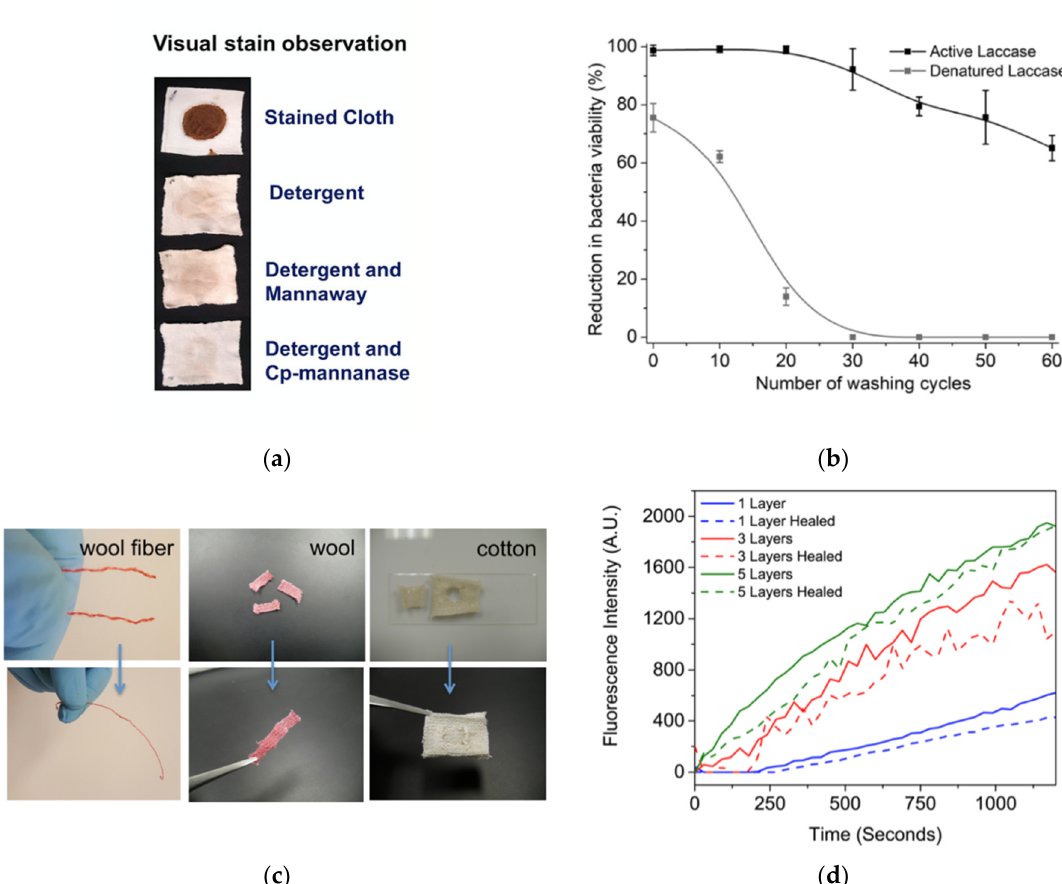
Figure 3. ( a ) Observation of chocolate stain removal as a result of enzyme and non-enzyme containing detergent washes. Reprinted with permission from ref. [4]. 2019 The Authors. ( b ) Comparison of active and denatured laccase enzymes in their antibacterial capacity, as represented by percent reduction in bacterial viability. Reprinted with permission from ref. [5]. 2018 Elsevier. ( c ) Visual representation of wool and cotton textile samples before and after self-healing. Reprinted with permission from ref. [6]. 2016 American Chemical Society. ( d ) Efficiency of enzymatic activity, as represented by fluorescence intensity, of multilayer systems both before and after the self-healing process. Reprinted with permission from ref. [6]. 2016 American Chemical Society.